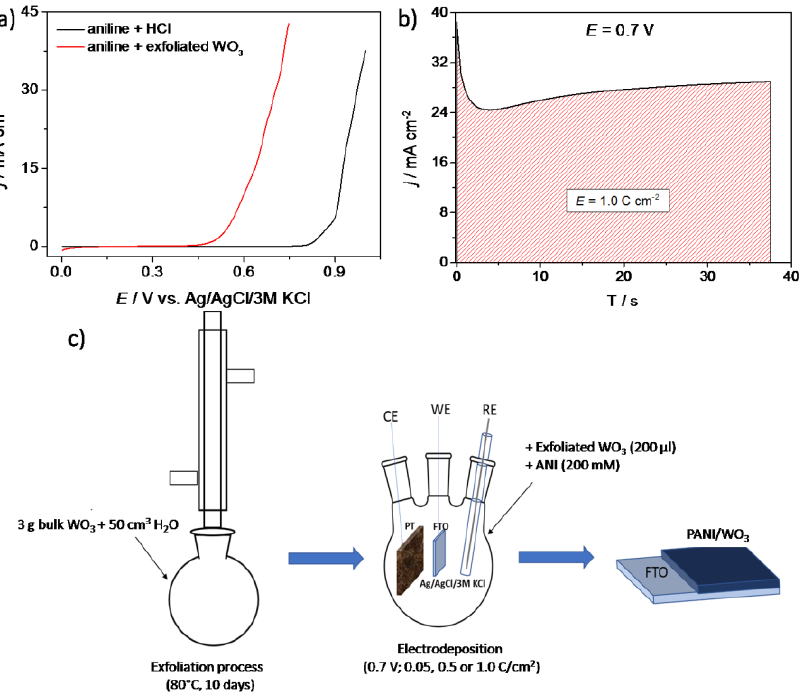
Figure 1. ( a ) The linear sweep voltammetry curves obtained during polarization of FTO electrodes in an aqueous electrolyte containing aniline / HCl (black curve) and aniline / exfoliated WO 3 (red curve); ( b ) a chronoamperometry curve recorded during PANI / WO 3 electrodeposition and ( c ) the diagram depicting the preparation process of the FTO / PANI / WO 3 composite.